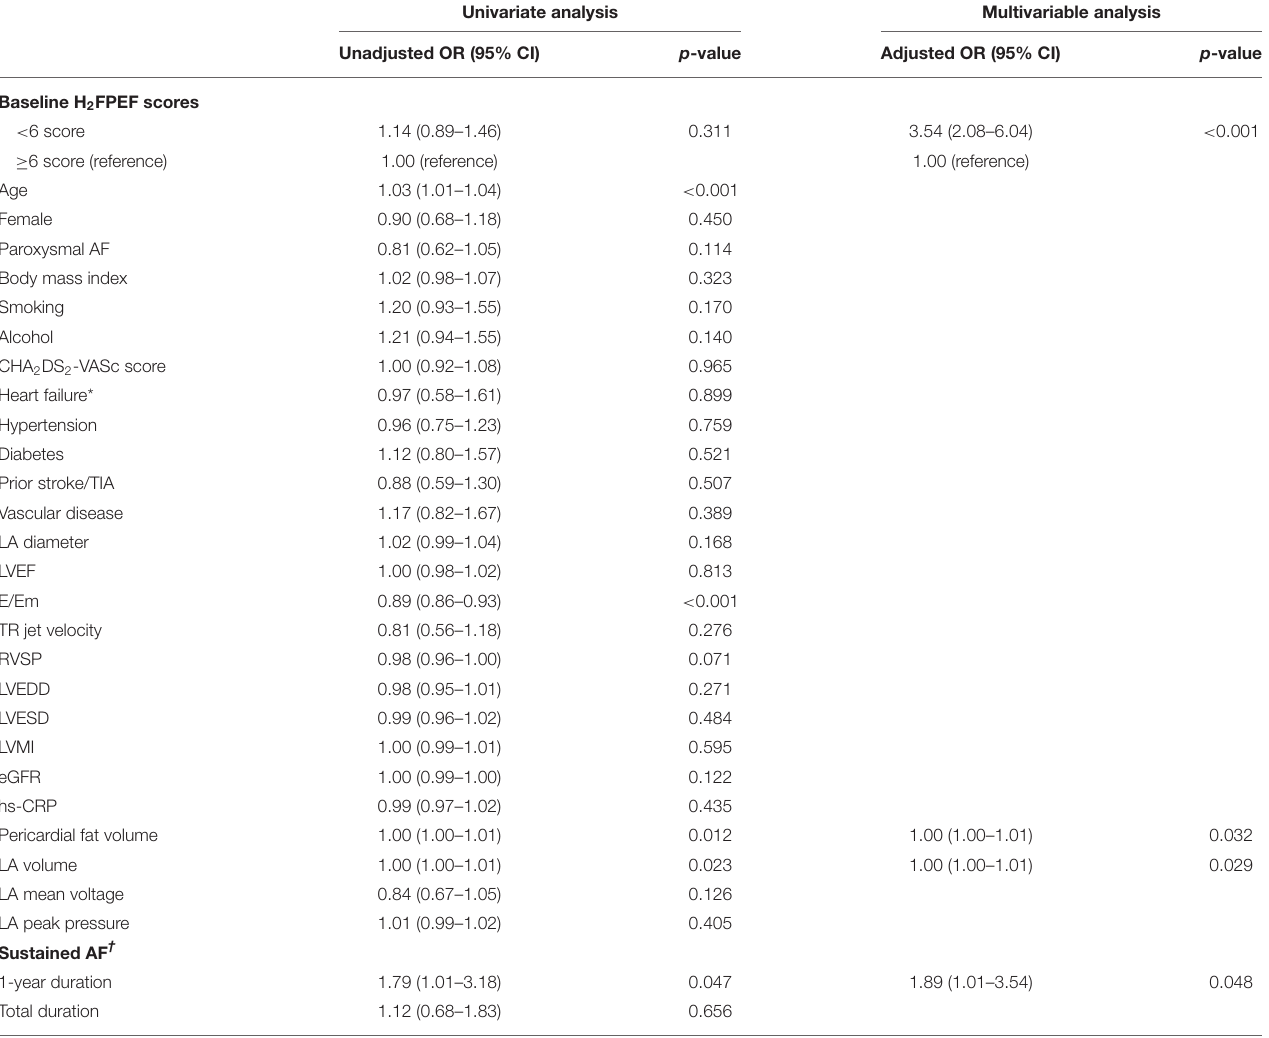
TABLE 4 | Logistic regression analysis for predictors of increased H 2 FPEF scores, 1-year after the AFCA. Univariate analysis Multivariable